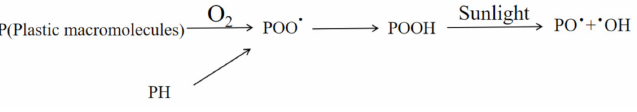
Figure 1. The mechanism of